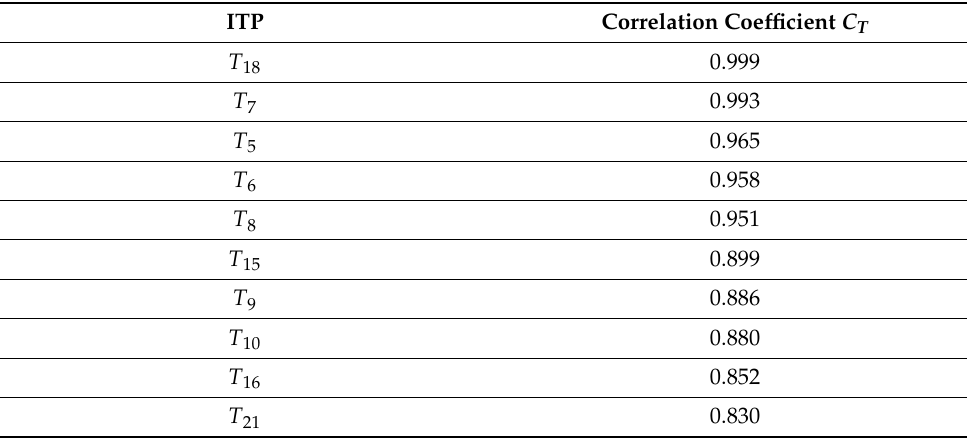
Table 4. The ten ITPs with the strongest correlations with T 17 .